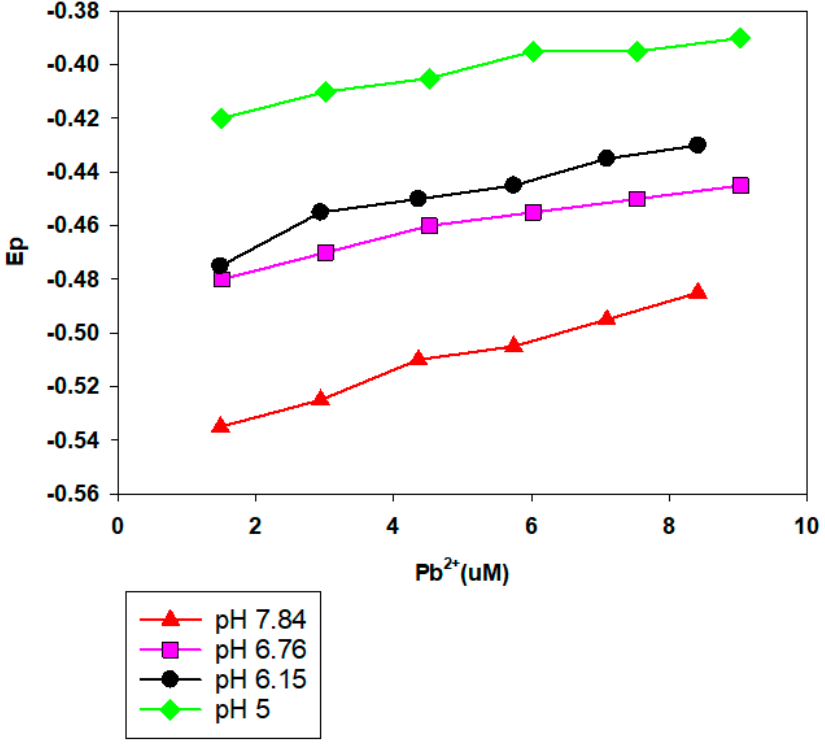
Figure 4. DPP results for Pb 2+ in the presence of 100-mg/L Pahokee peat humic acid at pH 5, 6.15, 6.76 and 7.84.